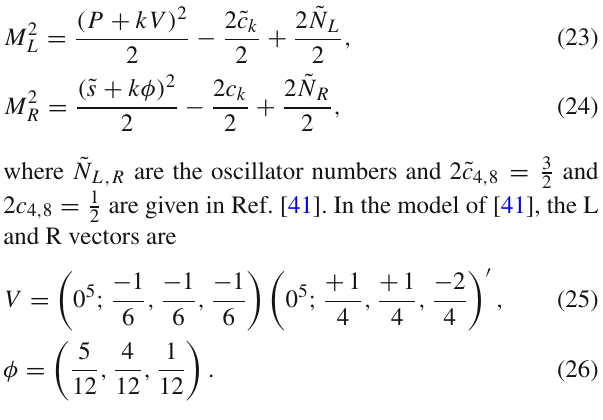
the orbifold selection rules for the vector-like states. Also, the thick arrow line for 5 + 2 does not appear in Table 2. These three states are denoted by the ‘vector-like states’ which are shown in Table 4. The left-mover and right-mover masses in the heterotic string with Z 12 − I compactification in the k th twisted sector are given